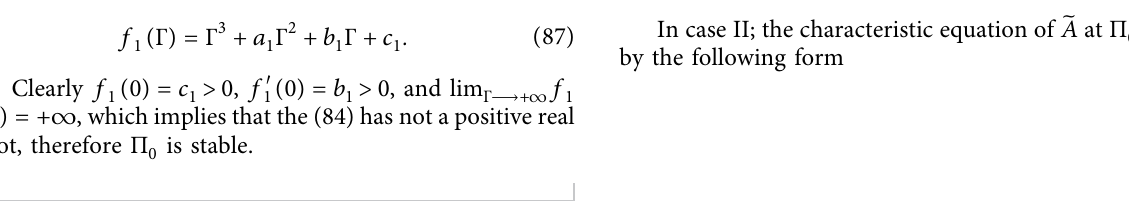
Figure 1: Solution of system (75) with the initial conditions (77), for Case I. R G.A.S. (a, b) Target cells. (c, d) DENV-infected cells. (e) DENV particles. (f) Heterologous antibodies. (g) Homologous